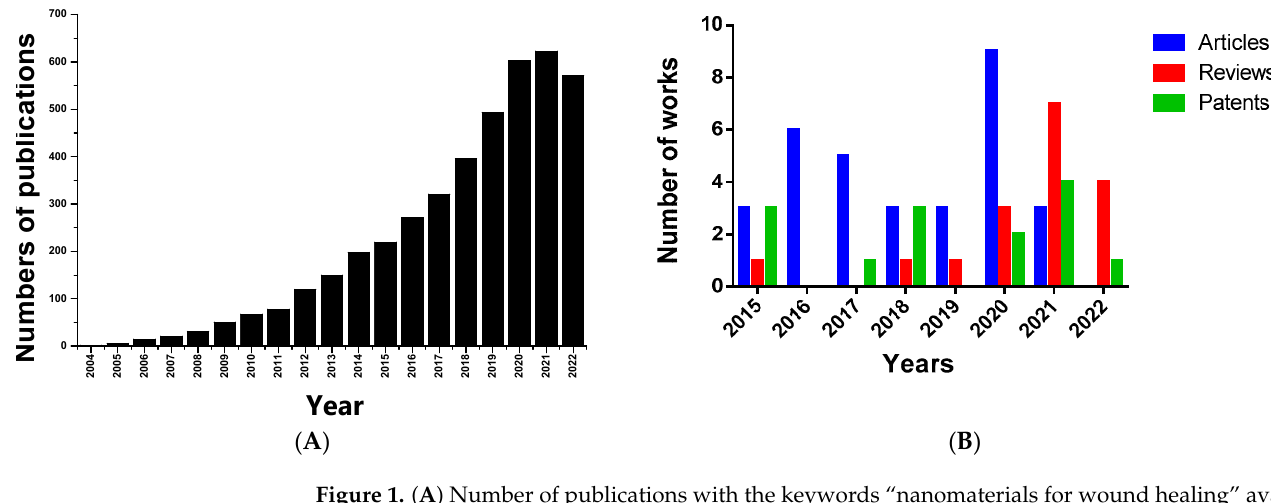
Figure 1. ( A ) Number of publications with the keywords “nanomaterials for wound healing” avail- able in PubMed from 2004 to 2022 (obtained on 8 November 2022). ( B ) Number of publications (articles and reviews) and patents with the keywords “honey or propolis + nano + wound healing + scaffold” available in scientific publications and patent finders (WIPO and Espacenet) from 2015 to 2022 (obtained on 8 November